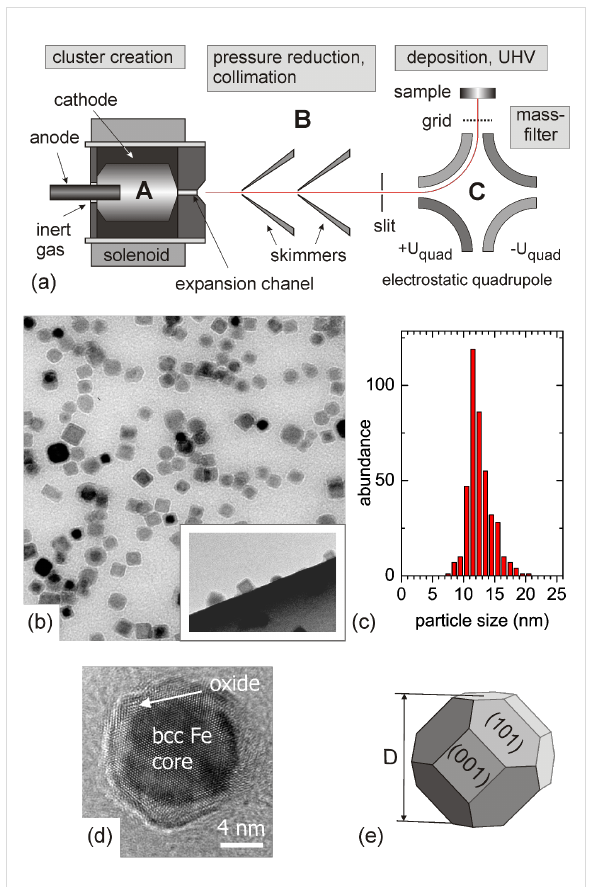
Figure 1: (a) Schematic drawing of the ACIS. (b) TEM image of a typical nanoparticle deposit on a carbon coated copper grid. The side view in the inset reveals compact three-dimensional shapes. (c) Size distribution of Fe particle sizes from (b) including the oxide shell. (d) High resolution TEM image of a single particle showing a 2 nm thick oxide shell surrounding the crystalline Fe core. (e) Schematics of the equilibrium shape of pure crystalline Fe particles as expected from a Wulff construction in the present particle size range